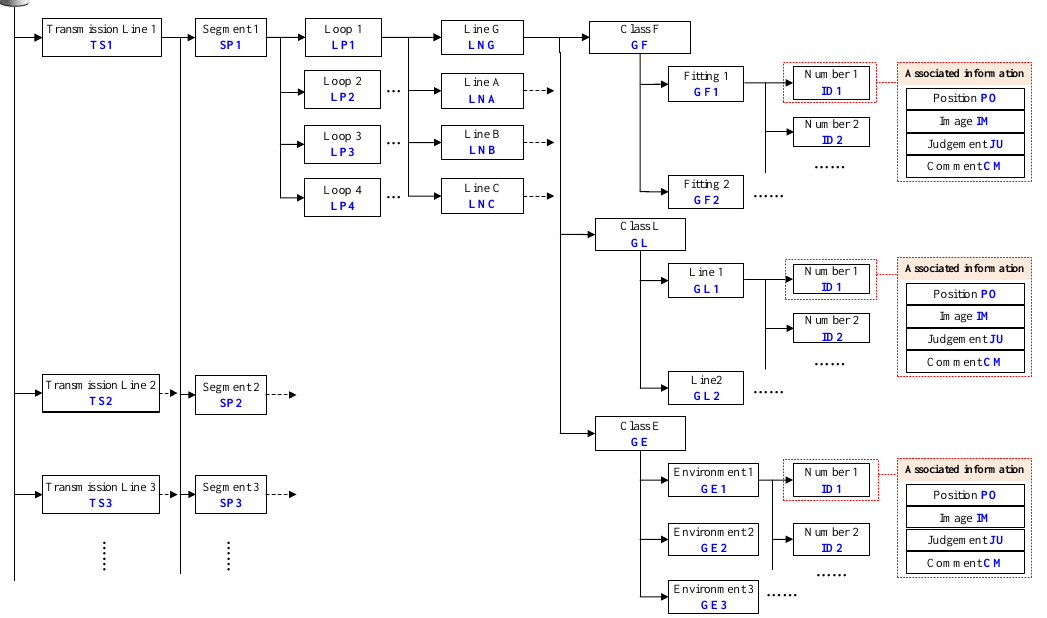
Figure 11. The schematic diagram of the database structure of a waiting-inspection target.